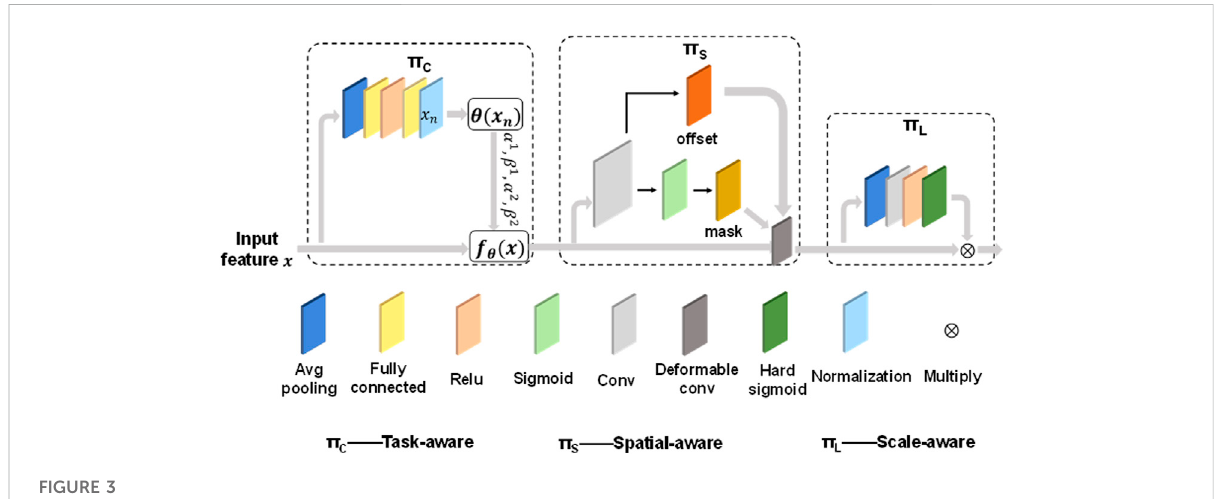
FIGURE 3 The overall structure of Dynamic